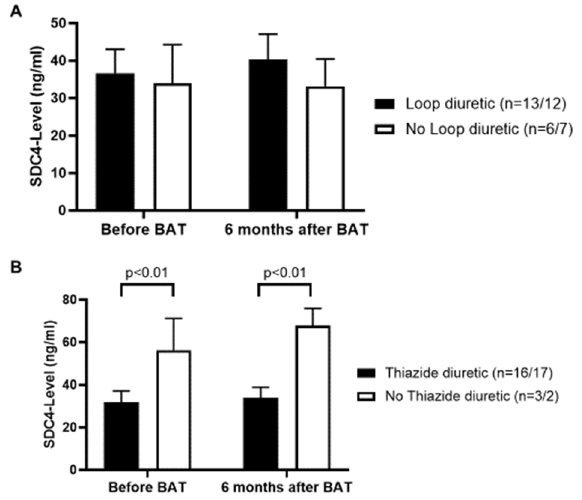
Figure 5. ( A ): Both angiotensin-converting enzyme (ACE)-inhibitors and angiotensin receptor blockers (ARBs) show no correlation to serum SDC4-levels. ( B ): With no β-blocker treatment SDC4- levels are significantly higher as compared to treatment with β-blockers. ( C ): Treatment with calcium channel blockers is associated with increased serum SDC4-levels. ( D ): α-blockers do not alter serum SDC4-levels. The first number of n represents patient numbers before BAT. Second number of n represents patient number 6 months after BAT implantation. If there is only one number of n mentioned, it means that the number of patients taking that medication has not changed after the 6- month interval. Values are given as means ± SEM.